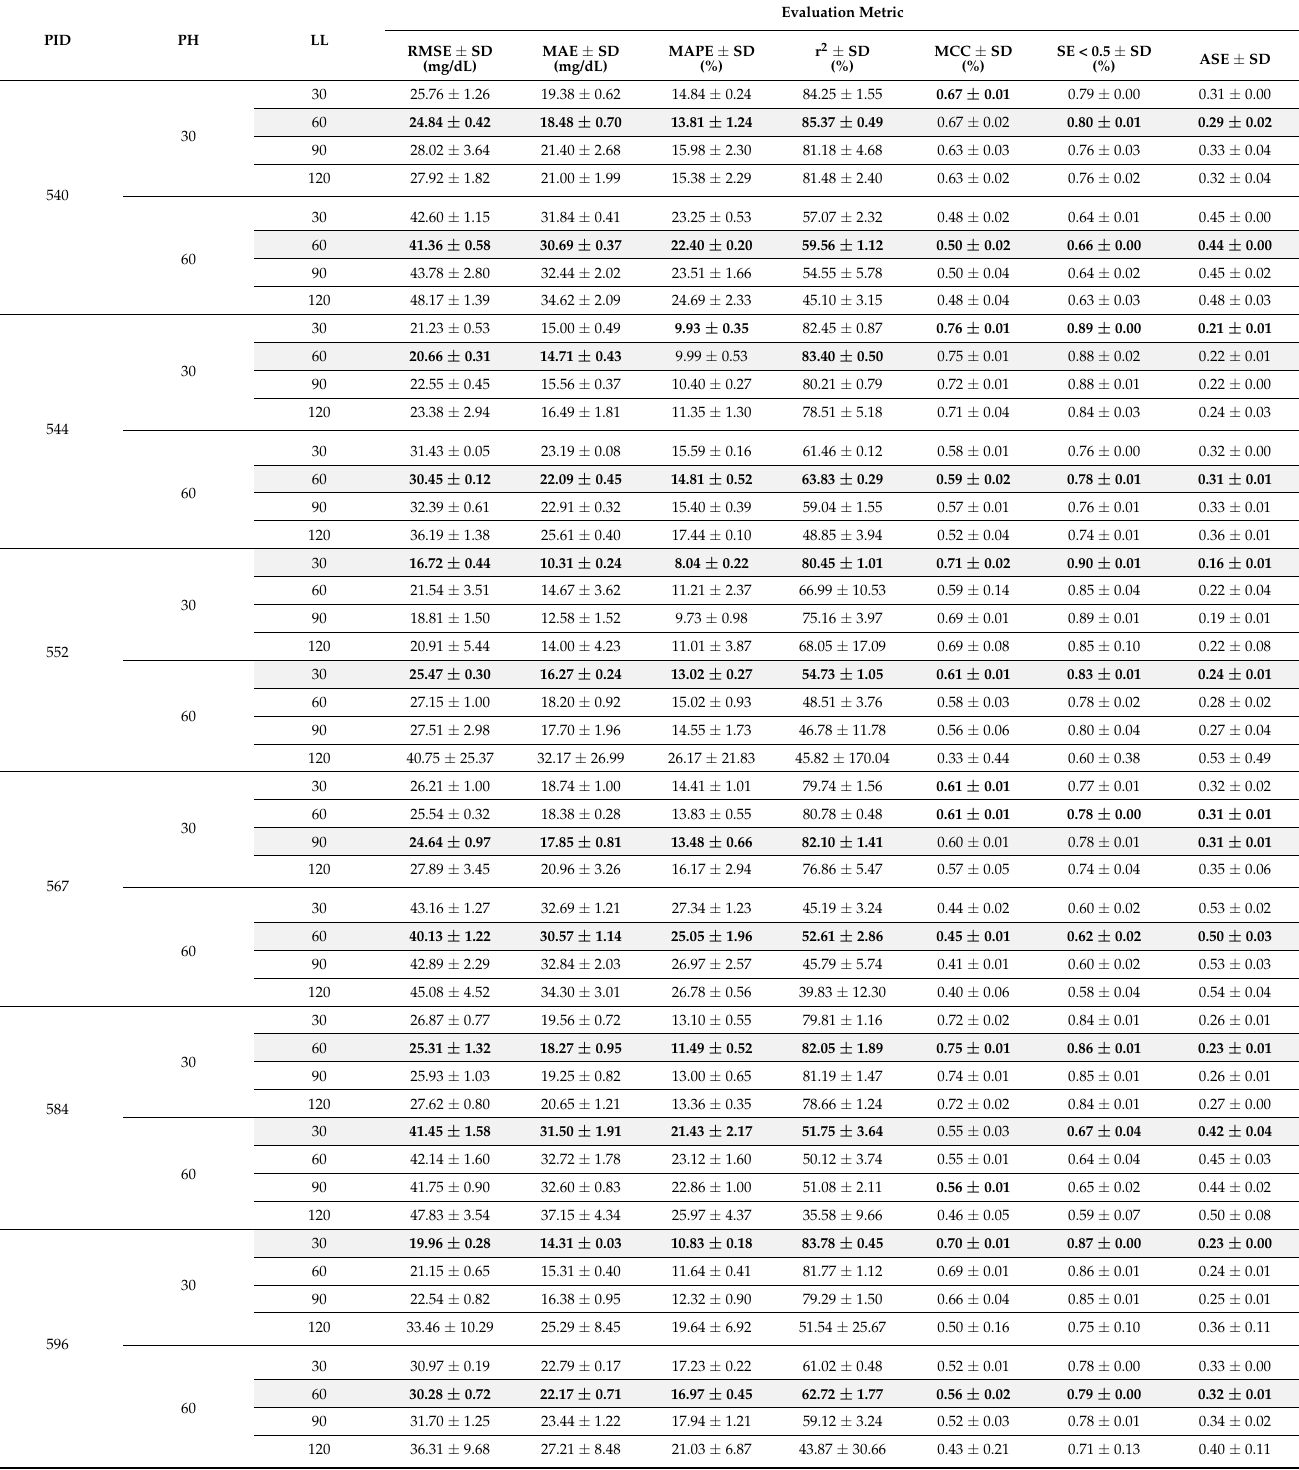
Note. Values in bold indicate the best evaluation outcome for each metric in each learning scenario, and grey highlights denote the best model in each scenario based on the best-achieved evaluation metrics. Note. PID: patient identification; PH: prediction horizon; LL: lag length; RMSE: root mean square error; SD: standard deviation; MAE: mean absolute error; MAPE: mean absolute percentage error; r 2 : coefficient of determination; MCC: Matthew’s correlation coefficient; SE: surveillance error; ASE: average surveillance